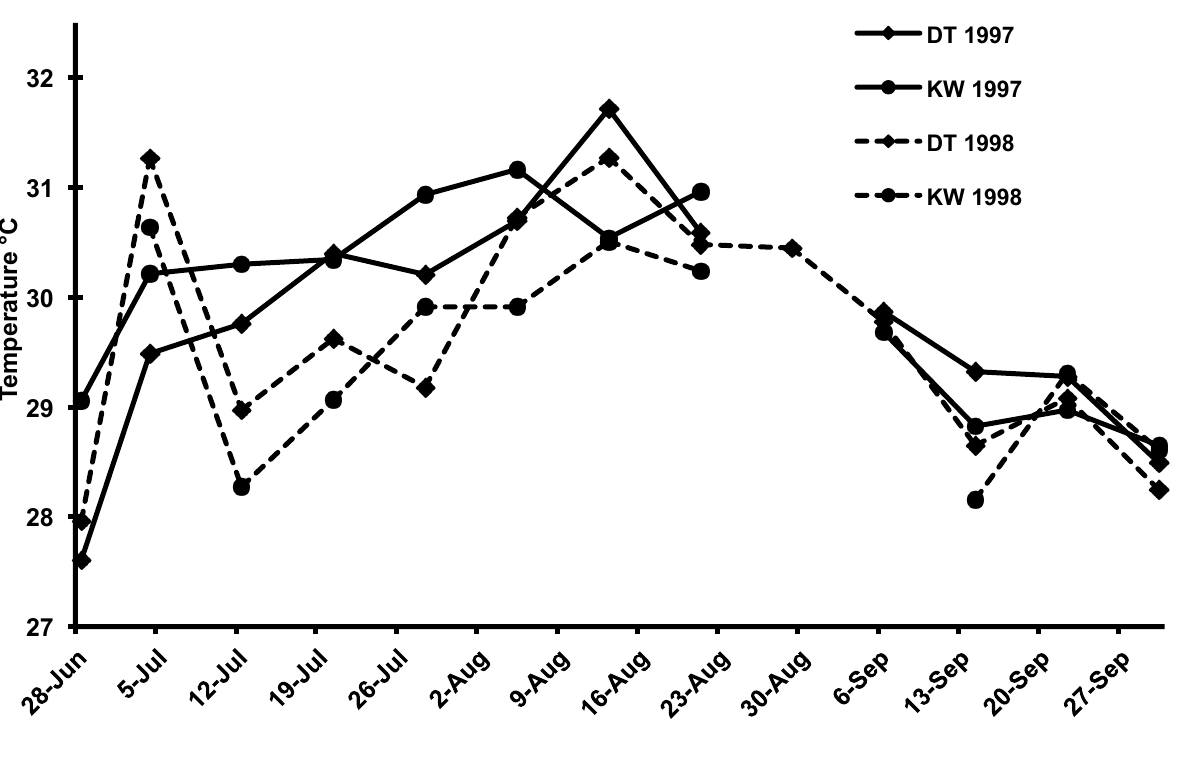
Figure 4. Weekly average sea-surface temperature in Dry Tortugas (DT) and Key West (KW) reef areas for June to September, 1997 and 1998 [34].